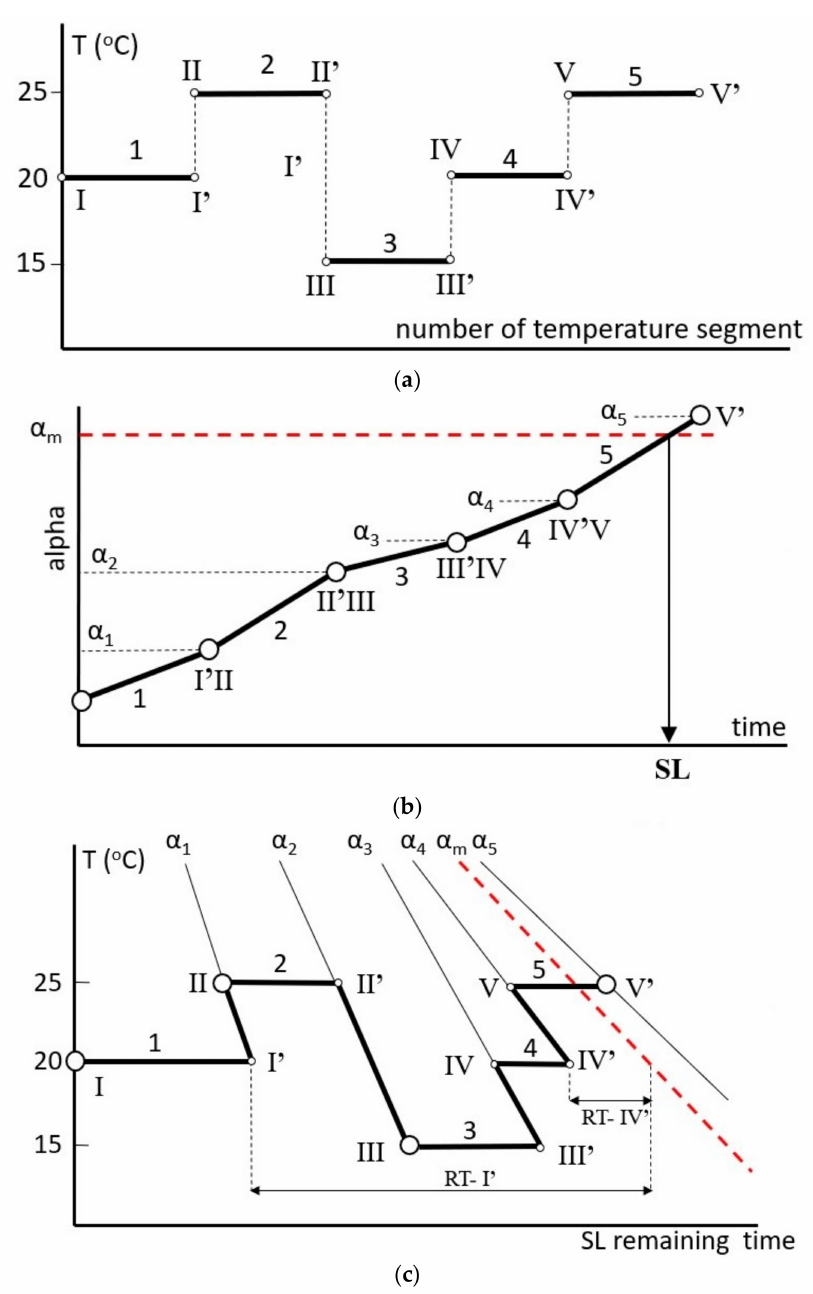
Figure 10. Scheme of the estimation of the remaining shelf life of the model vaccine during temperature variations. ( a ) Time–temperature dependence during the storage; ( b ) change of the reaction extent, α , as a function of the time and temperature profile shown above, the dashed line presents the maximal acceptable degradation extent which determines the shelf life value; ( c ) TTT plot presenting the mutual dependence of the time, temperature, and reaction progress. The dashed line (plot 10b) depicts the maximal acceptable degradation degree and their intersection with the actual degradation extent indicates the time in which the shelf life (SL) is reached. The determination of the remaining shelf life during storage displayed in Figure 10c is explained in the